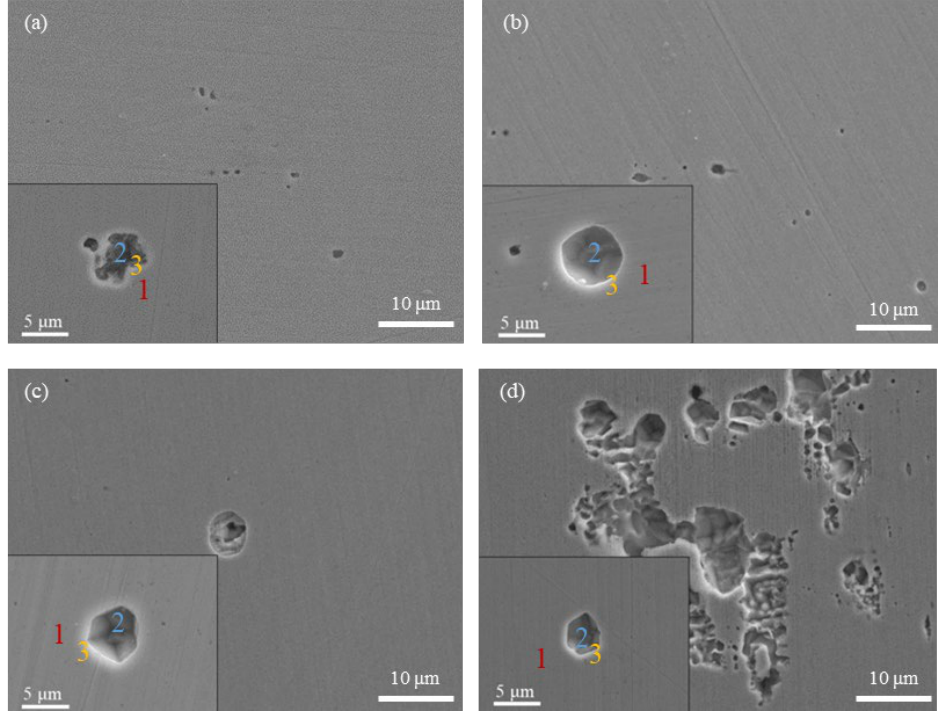
Figure 4. SEM images of 304 SS after polarization in an 0.6 mol/L NaCl solution, with different concentrations of HAc: ( a ) without HAc, ( b ) 0.8 mol/L HAc, ( c ) 1.6 mol/L HAc, ( d ) 3.2 mol/L HAc.